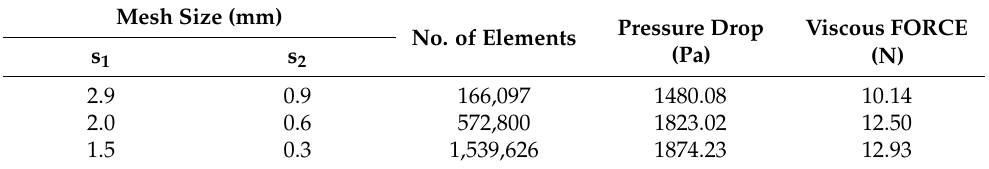
Table 1. Grid independence test for the model of a capsule moving in a straight pipeline.